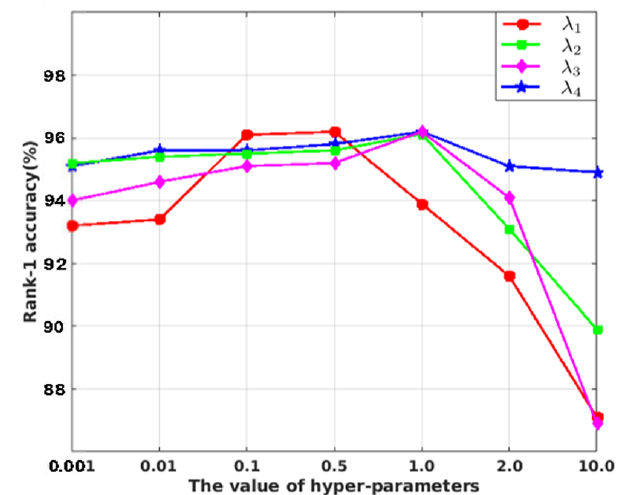
Figure 9. Parameter analysis on VeRi-776 [3]. Sensitivity to the λ i ( i = 1,2,3,4 ) parameters in the final objective